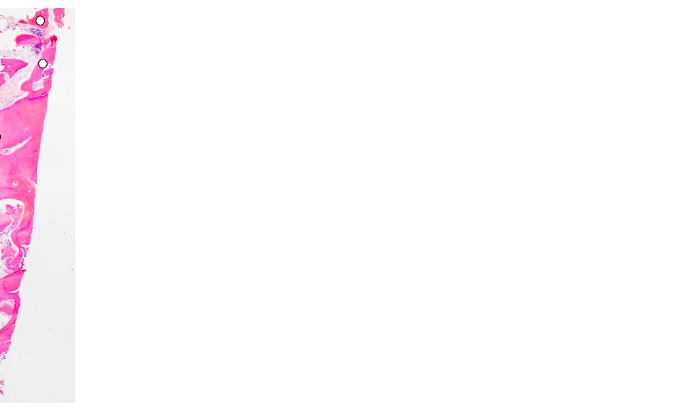
Figure 2. Histology extracted from a site with membrane, with a circle for the bone and a star for the tooth graft. New bone was 41.67%, residual graft was 5.65%, and total calcificated tissue was 47.33%.